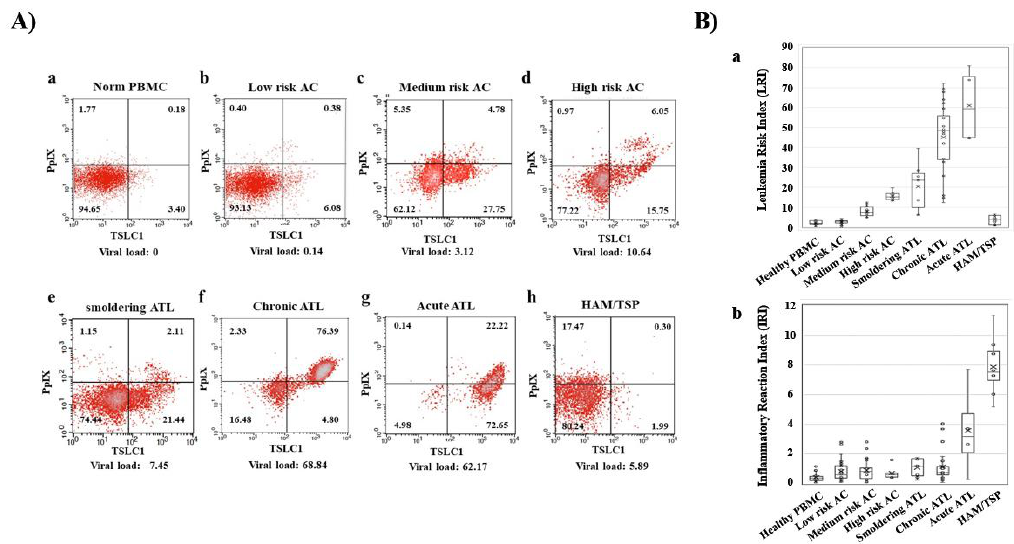
Figure 2. Dynamic changes of Flow cytometry (FCM) profiles during onset and progression of ATL. ( A ) FCM profiles with the Protoporphyrin IX (PpIX)/TSLC1 parameters indicating the dynamic